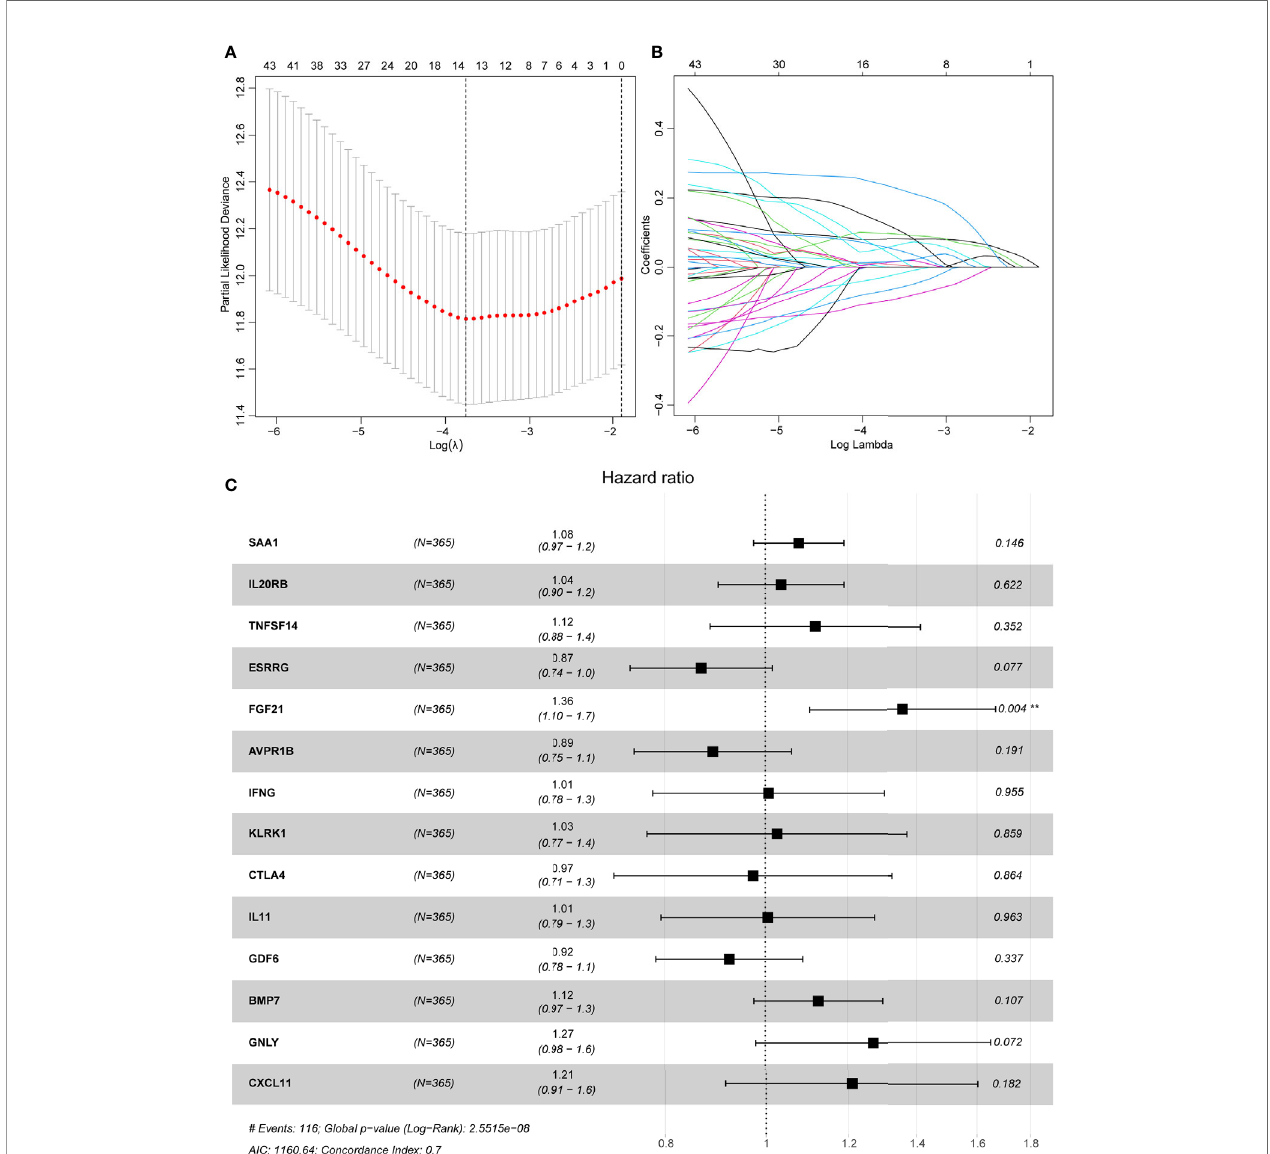
FIGURE 3 | LASSO regression analyses and a forest plot describing Cox regression model fi ndings of 14 immune-associated genes. (A) Partial likelihood deviance with changing of log ( l ) plotted by LASSO regression in 10-fold cross-validations. Vertical dotted lines were described at the optimal values using minimum criteria and the 1-SE criteria. (B) The LASSO coef fi cient pro fi les for 14 DE-IRGs in the 10-fold cross-validation. (C) Forest plot representing correlations between the expression levels of 14 DE-IRGs and overall survival outcomes in the training dataset. HR, 95% CI, and P-values were evaluated by LASSO regression analyses. ** means P <